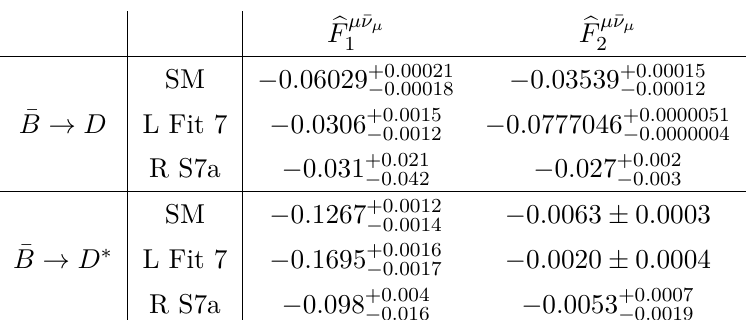
for the ¯ B → D ( ∗ ) τ ( µ ¯ ν µ ν τ )¯ ν τ decay evaluated 1 , 2